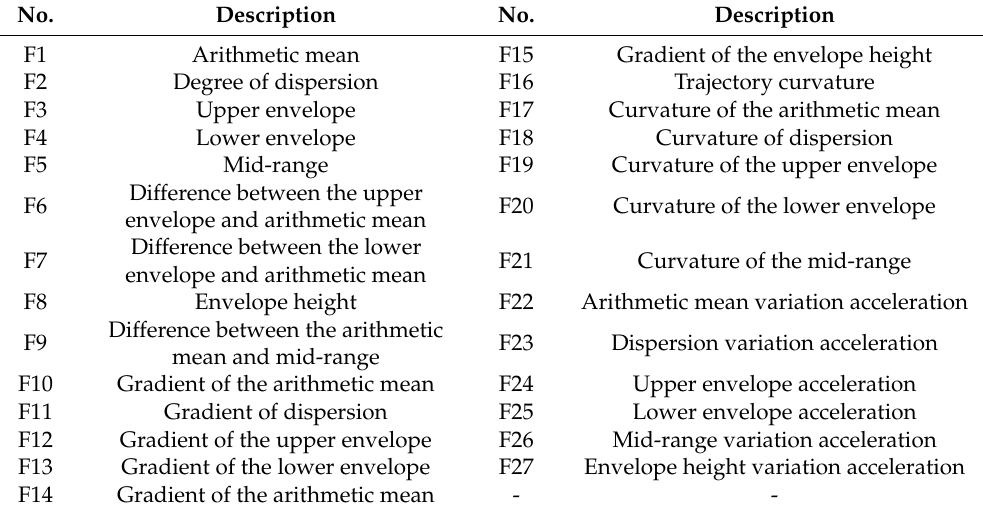
Table 1. Description of the 27 extracted trajectory cluster